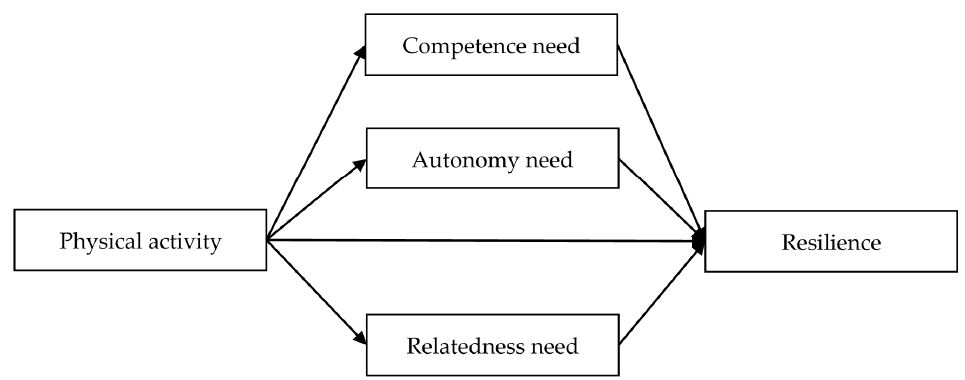
Figure 1. Structural framework.